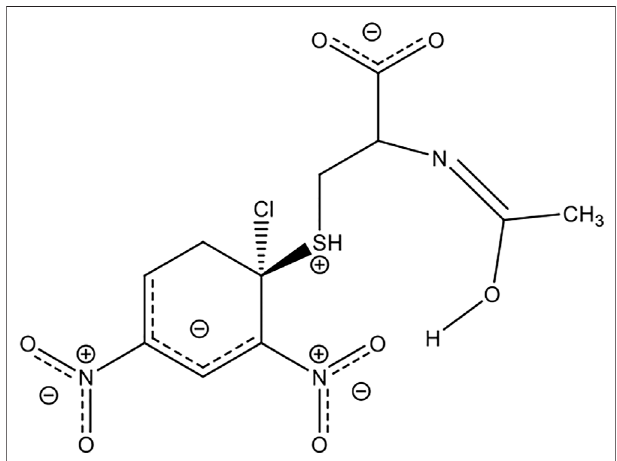
FIGURE 8 | Representation of possible interaction between the substrate and